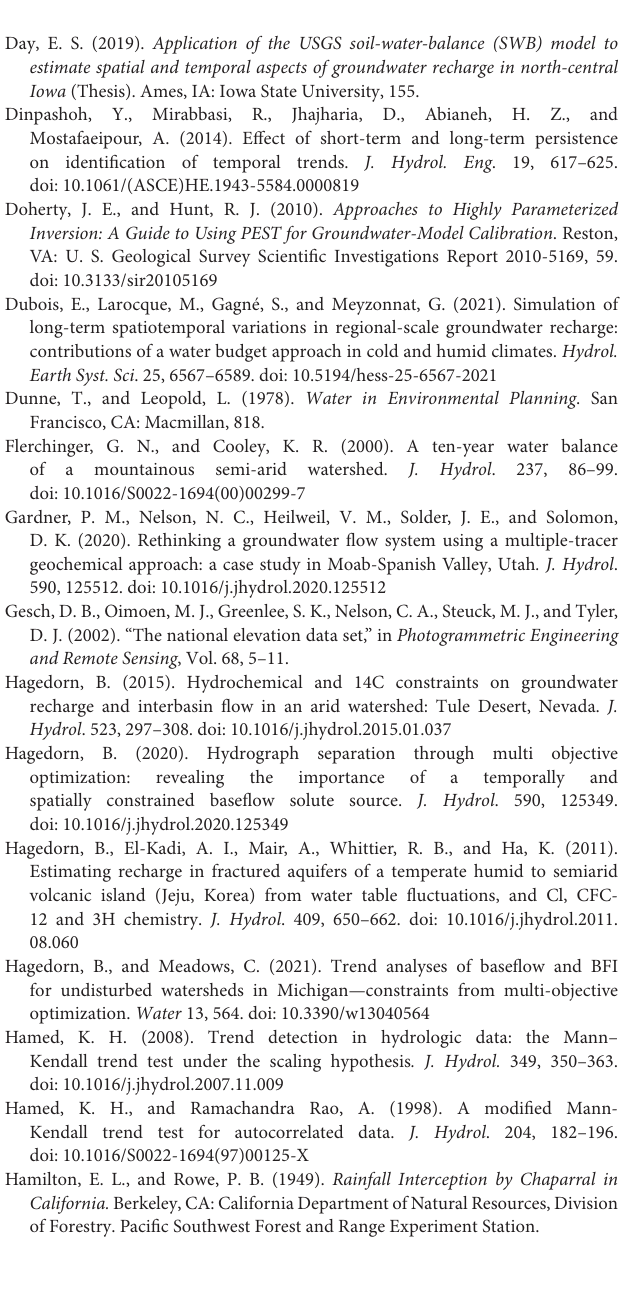
Figure A1 | Land use lookup table with parameters defined for each land use-HSG combination (HSG A–D as 1–4) for the baseline run. Highlighted cells display values inconsistent with expected pattern of consecutively decreasing infiltration rates from soil groups A–D. Figure A2 | MK Trend test results for annual recharge (R) and surface runoff (SR) in the South Fork Tule River watershed over time period 1981–2019. Trends are assessed at the 5% significance